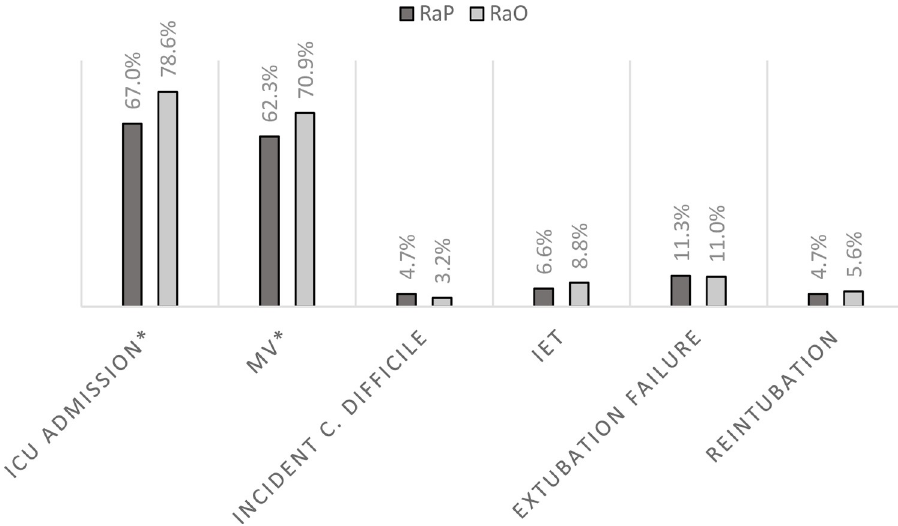
Fig 2. Index hospitalization complications. RaP = readmission for pneumonia; RaO = readmission for another condition; ICU = intensive care unit; MV = mechanical ventilation. � P = 0.005. �� P = 0.059.